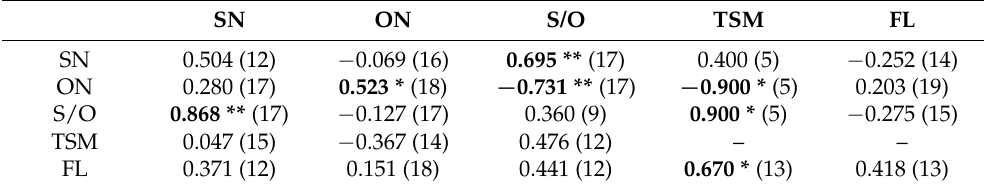
Table 3. Correlation (Spearman’s ρ ) between studied parameters in 2021 in field trial (lower left part of the matrix), glasshouse trial (upper right part of the matrix), and between two trials (diagonal). Numbers of compared accessions are given in brackets.